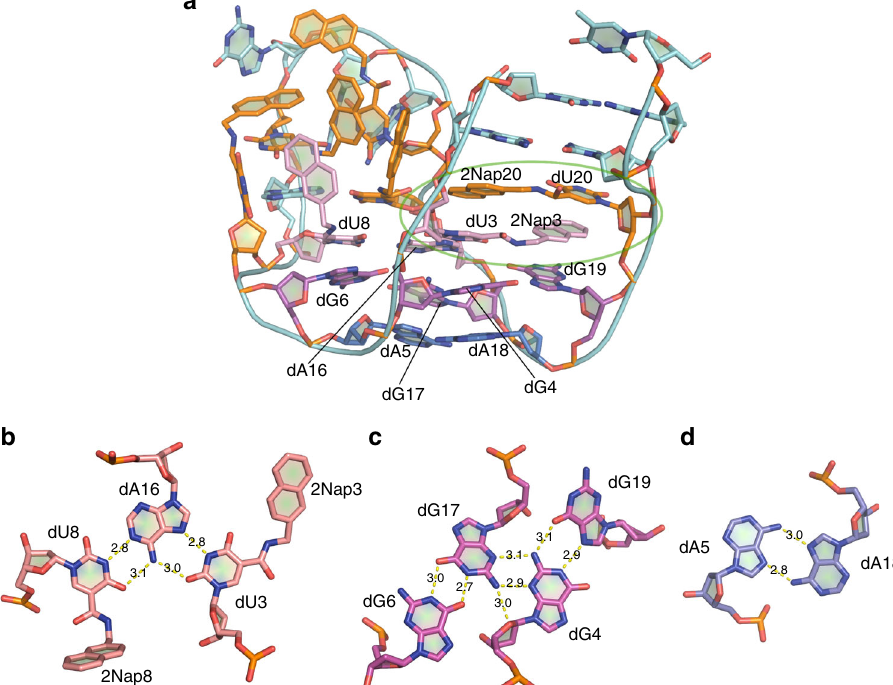
Fig. 2 Important structural motifs in SL1067. a Overall structure of SL1067 with the nucleotides that participate in the formation of three important motifs colored as mentioned below. The zipper motif is indicated by a green oval . b The dU3-dA16 = dU8 triple is colored pink . c The G-quadruplex is colored magenta . d The bottom dA5 – dA18 pair is colored